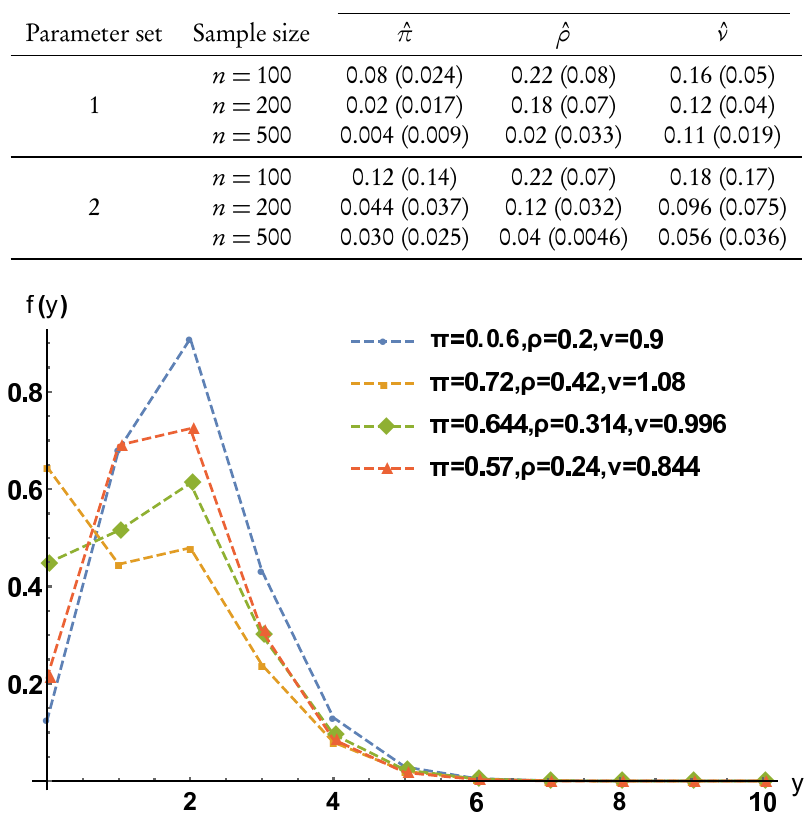
Figure 12 – Probability plots corresponding to parameter set